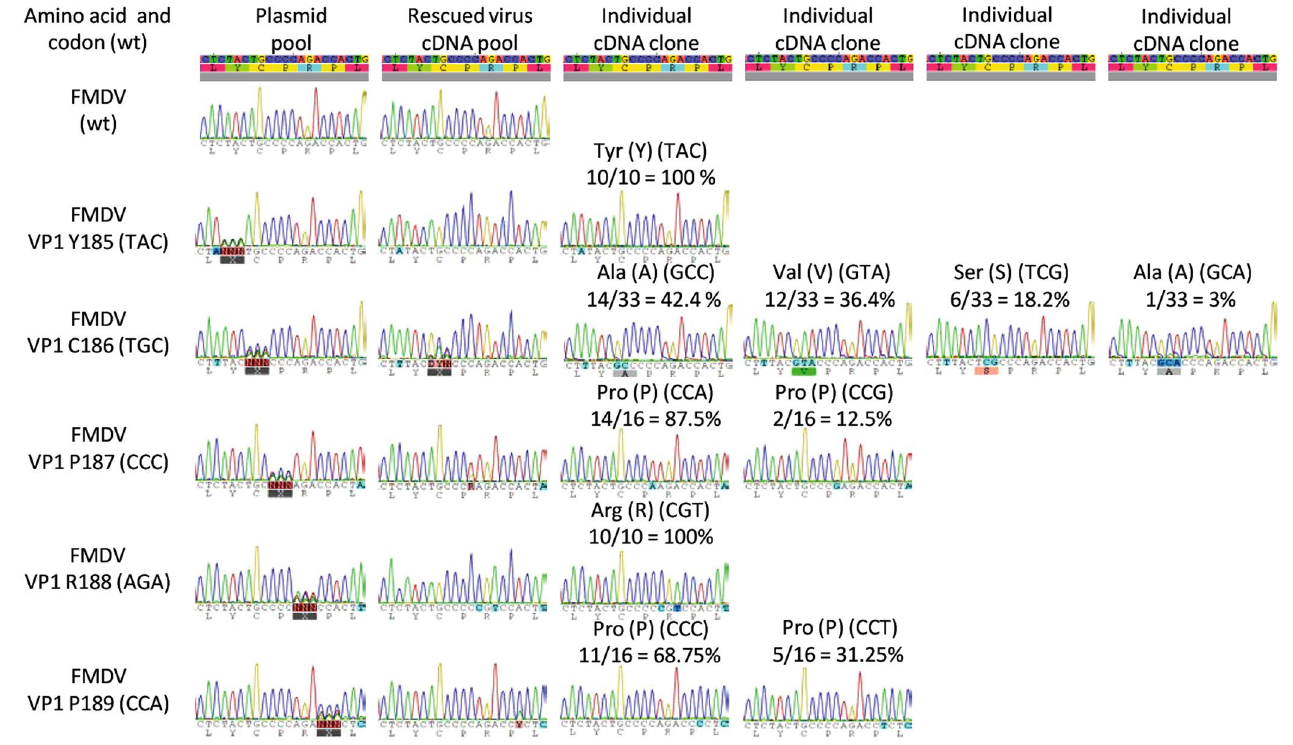
Figure 2. The plasticity of the YCPRP motif within infectious FMDV. Mutagenesis was performed on defective mutant full-length FMDV cDNA templates (see text) to modify the codon for each residue within the YCPRP individually to all possible codons (NNN). The pools of plasmids obtained were sequenced and the heterogeneity in each pool is shown. RNA transcripts were prepared from each mutant pool separately and introduced into cells to recover infectious virus. CPE was observed at passage 1 (c.f. the mutant template) in each case and then amplified through 2 passages in total. RNA was extracted from these rescued viruses, converted to cDNA and sequenced throughout the P1-2A coding region. No secondary substitutions were observed and heterogeneity was only observed within the sequence encoding the conserved motif in VP1. From each cDNA pool, a cDNA fragment, encoding VP1-2A, was amplified and inserted into a TOPO vector and individual clones (10–33) were sequenced. Representatives of the distinct individual sequences are shown together with the encoded amino acid sequence. The number and frequency (%) of each codon within the individual clones analyzed is shown. Note, within the rescued viruses, the presence of 4 distinct codons (encoding 3 different amino acids) at the position of C186, whereas only the wt TAC sequence (encoding Y) was present at the codon for residue 185. At the codons for residues P187, R188 and P189, only viruses with the wt amino acid were rescued but alternate (non-wt) codons were